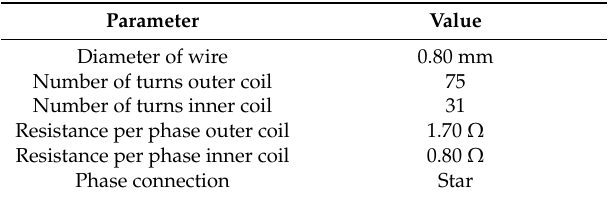
Table 3. Coil winding